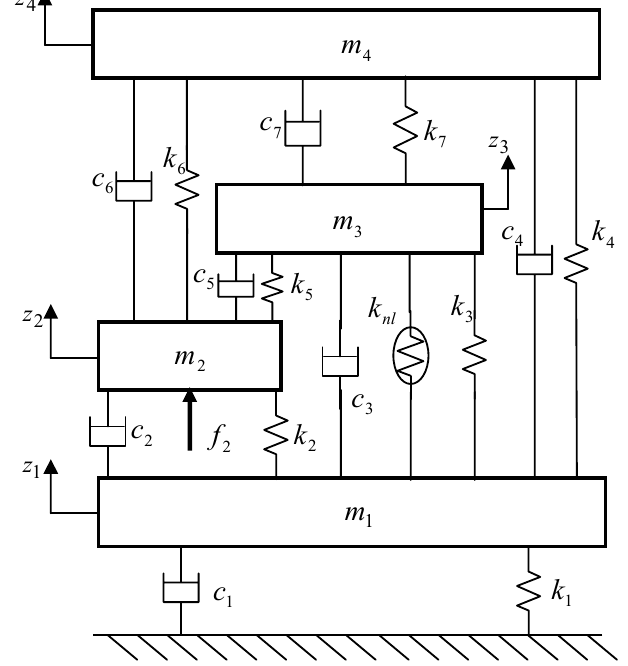
Fig. 1. 4-DOF nonlinear system with a cubic stiffness located between DOF 1 and 3.